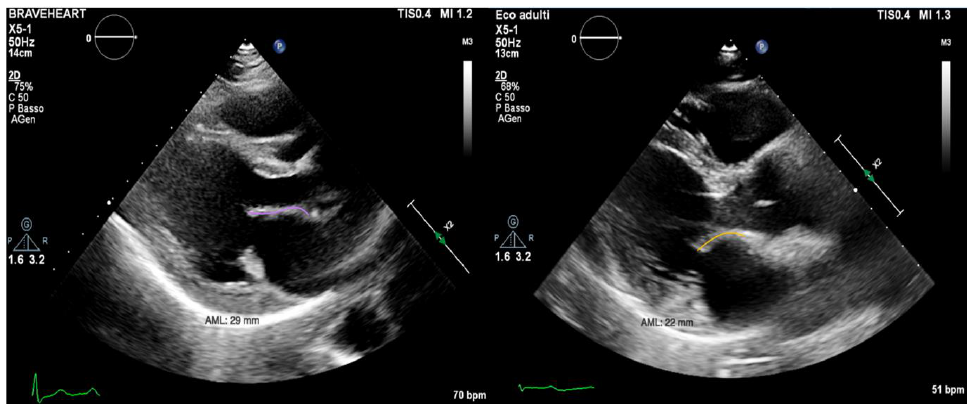
Figure 7. On the left, PLAX (parasternal long axis) view of a patient from the ICD-MVP group, with a longer AML (anterior mitral leaflet) (29 mm). On the right, PLAX view of a patient from the A-MVP group, with a shorter AML (22 mm).